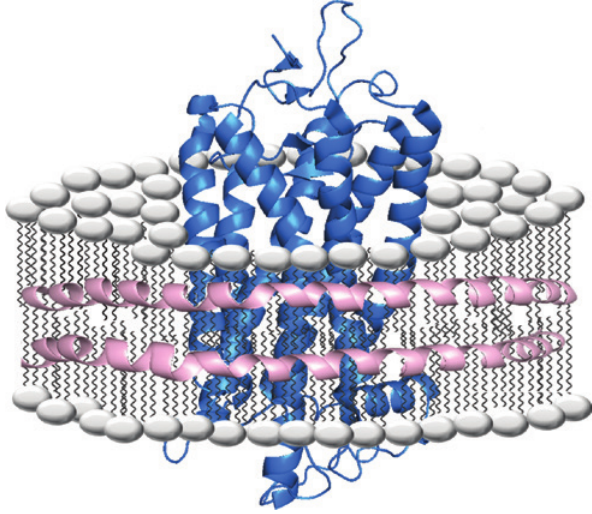
Figure 1: Schematic representation of a membrane protein embed- ded in a nanodisc. Monomeric rhodopsin (blue, PDB 1U19) is embed- ded within a central phospholipid bilayer core (gray) stabilized and surrounded by two molecules of a MSP (pink). MSPs are engineered forms of the apolipoprotein A-I, the major protein of HDL. ApoA-I has natural lipid-associating properties stabilizing a discoidal lipid bilayer of ~ 10-nm diameter [15,